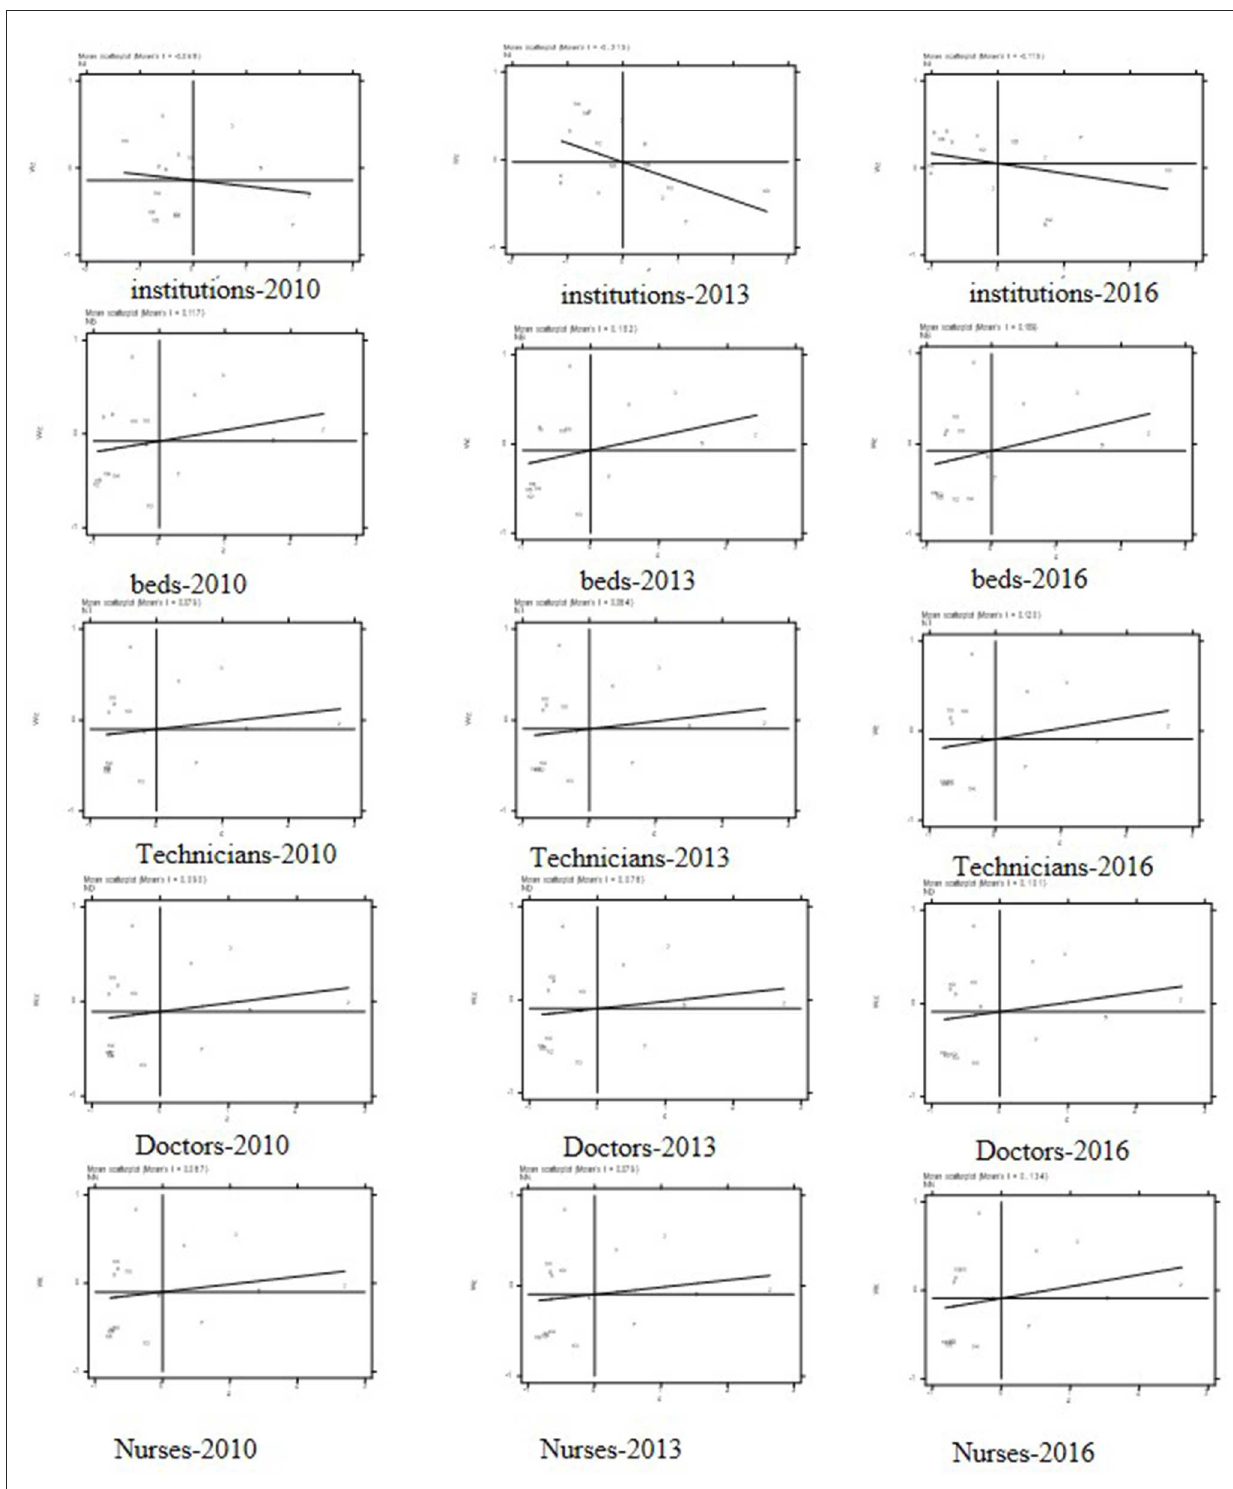
FIGURE1 Moran’s I scatterplots for institutions, beds, technicians, doctors, and nurses in 2010, 2013, and 2016.